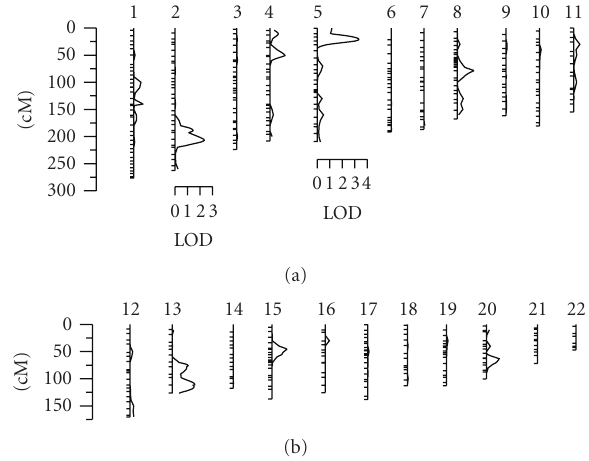
Figure 1: Multipoint genome-scan across the 22 autosomes for D-dimer levels in the San Antonio Family Heart Study. At all chromosomes, the vertical axis is in lod scores, and the horizontal axis is in centiMorgans (cM).